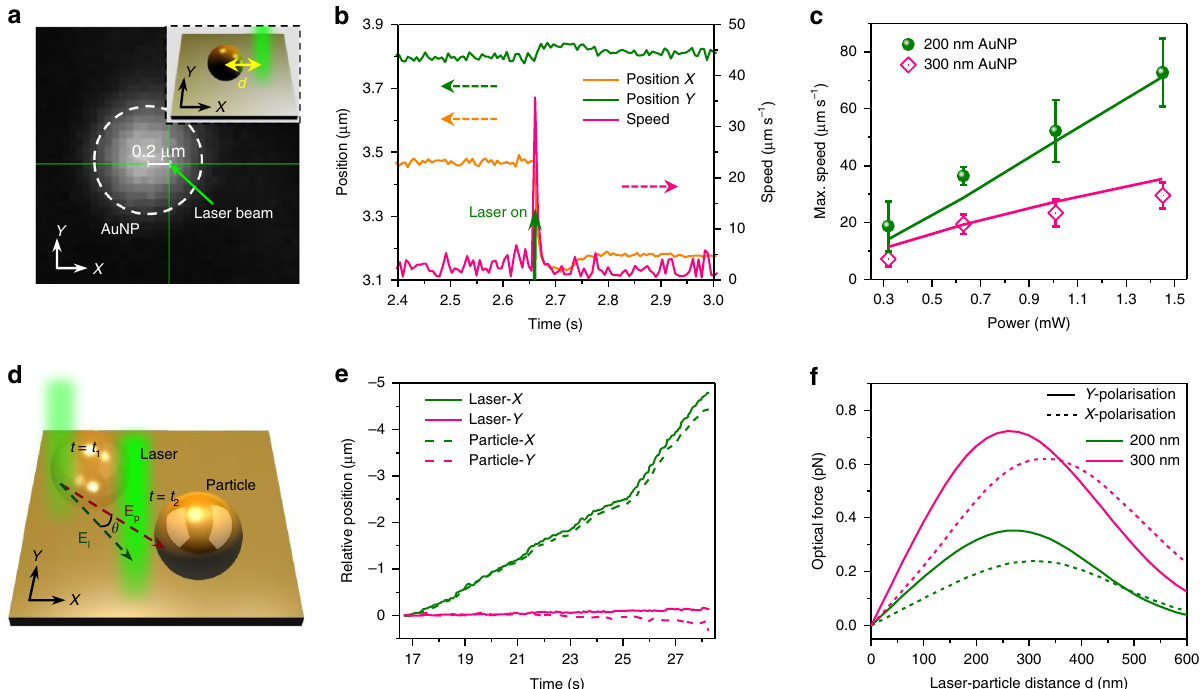
Fig. 2 Characterisation and modelling of the OPN manipulation process. a Optical image and (inset) the schematic illustration showing the measurement of particle velocities. The distance between the centre of the laser beam and the centre of the particle was set to 200 nm for all measurements. b The measured X position, Y position, and speed v of a 300 nm AuNP under the laser irradiation of 1.40 mW as a function of time t . The solid green arrow at t = ~2.7 s indicates the instant when the laser is turned on. c Measured maximum speed of 200 nm and 300 nm AuNPs as a function of incident power. The solid lines show the corresponding modelled data. d Schematic of the comparison of the laser movement vector E l and the particle movement vector E p at two successive frames ( t = t 1 , t 2 ). θ is denoted as the angle between E l and E p . e Examples of the recorded trajectories of the laser beam and the particle during the manipulation (see Supplementary Movie 1 for the manipulation of the 80 nm AuNP). f The calculated optical scattering forces of 200 nm (olive) and 300 nm (pink) AuNPs as a function of laser-particle distance. Incident power: 1.4 mW. Source data are provided as a Source Data fi